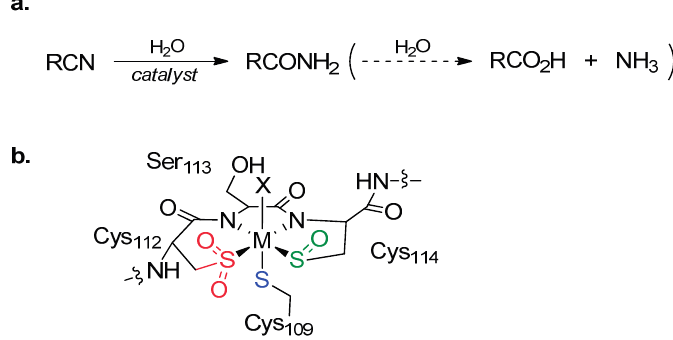
Figure 1. ( a ) Nitrile hydration to the primary amide (and onward to carboxylic acid and ammonia); ( b ) The metal binding environment at the active site of Co-NHase [22]. The metal is coordinated by two nitrogen atoms from backbone amides and three sulfur atoms; all the S -ligands derive from the side-chain thiols of cysteine residues, but each is in a different oxidation state: thiolate (blue), sulfenate (green) and sulfinate (red). X =